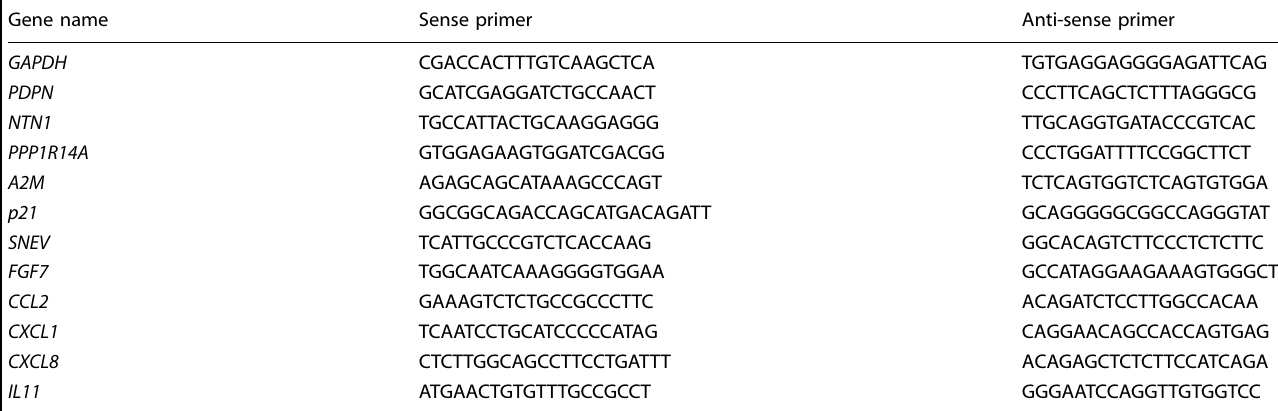
Table 1. Sequences of RT-qPCR